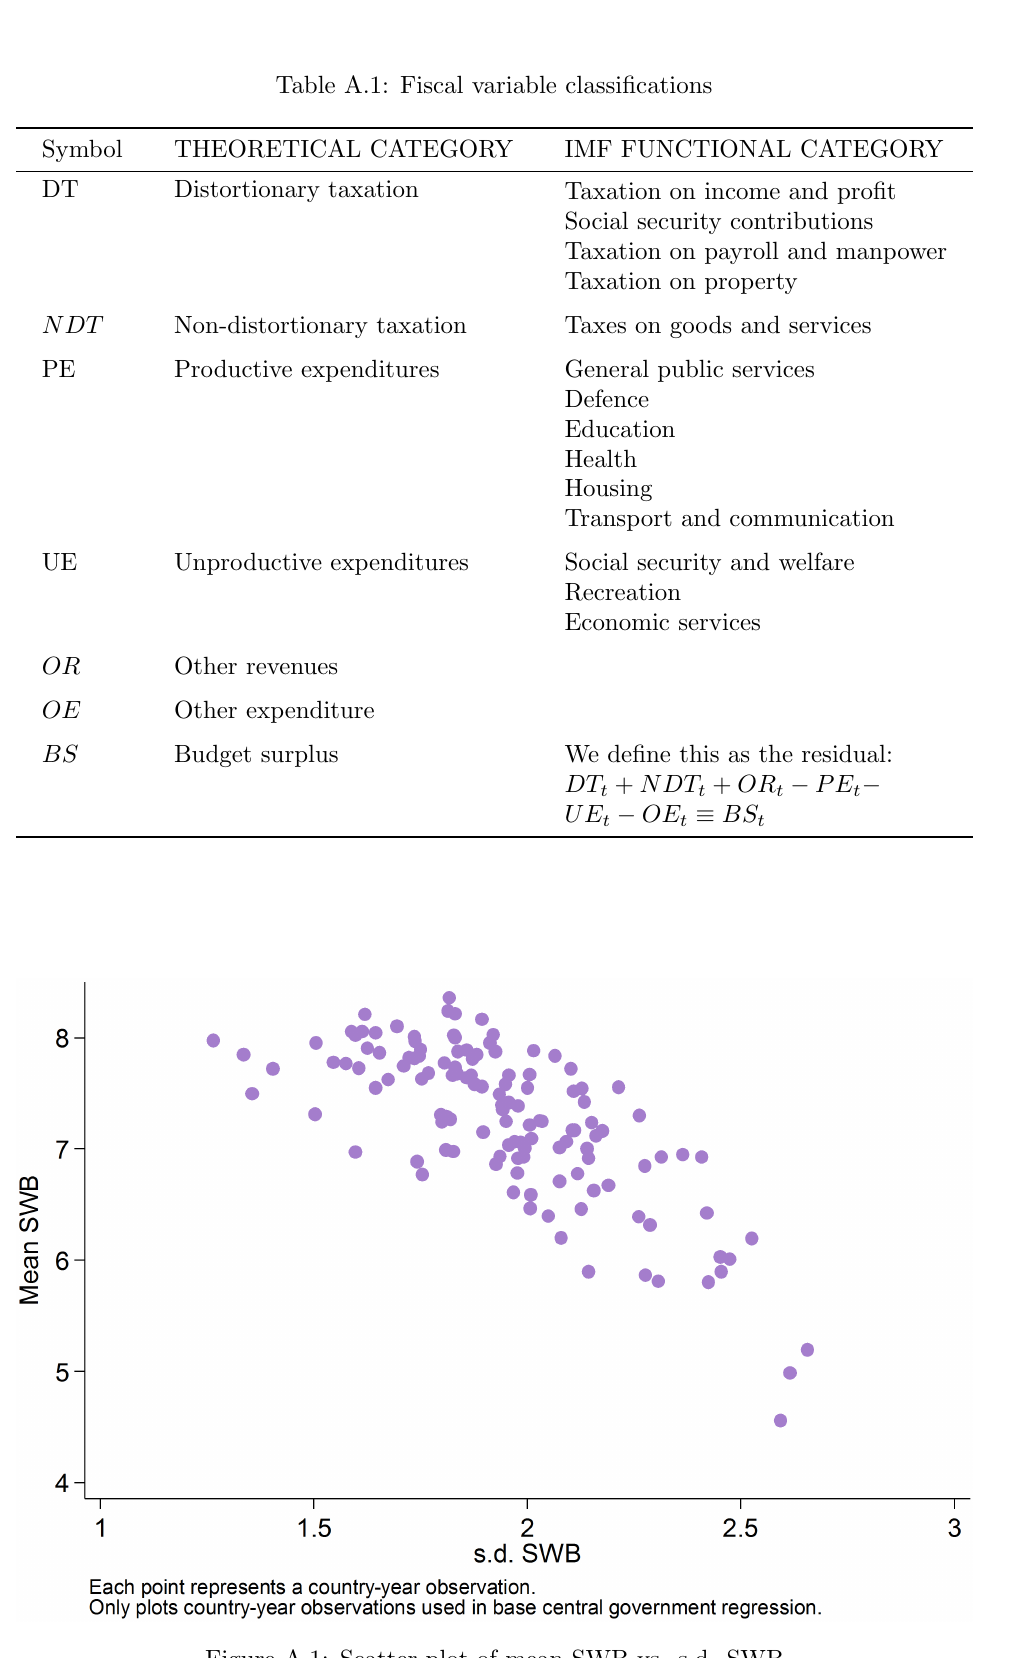
REGION : Volume 3, Number 1,